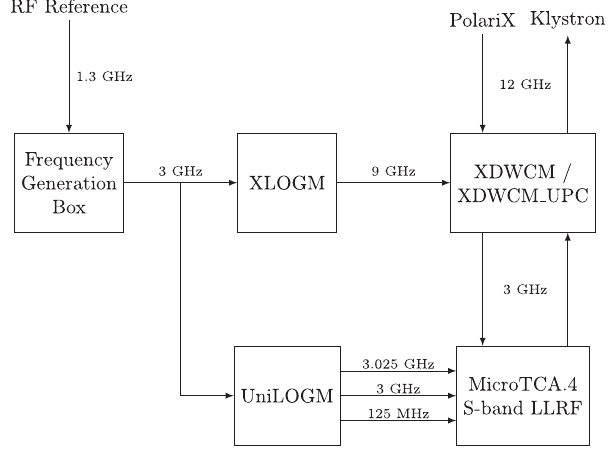
FIG. 36. Sketch of the LLRF concept for the integration of the PolariX TDS in the FLASH